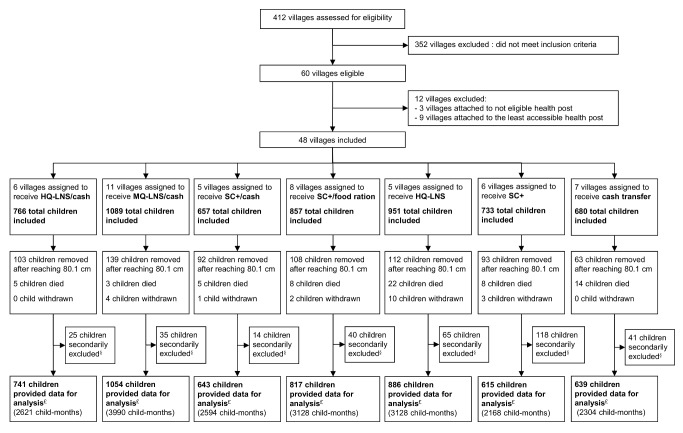
Intervention assignment and study flow of participants.
§Did not meet the inclusion criteria (were not living in a study village or were not the child initially enrolled). £All included children minus secondarily excluded children.